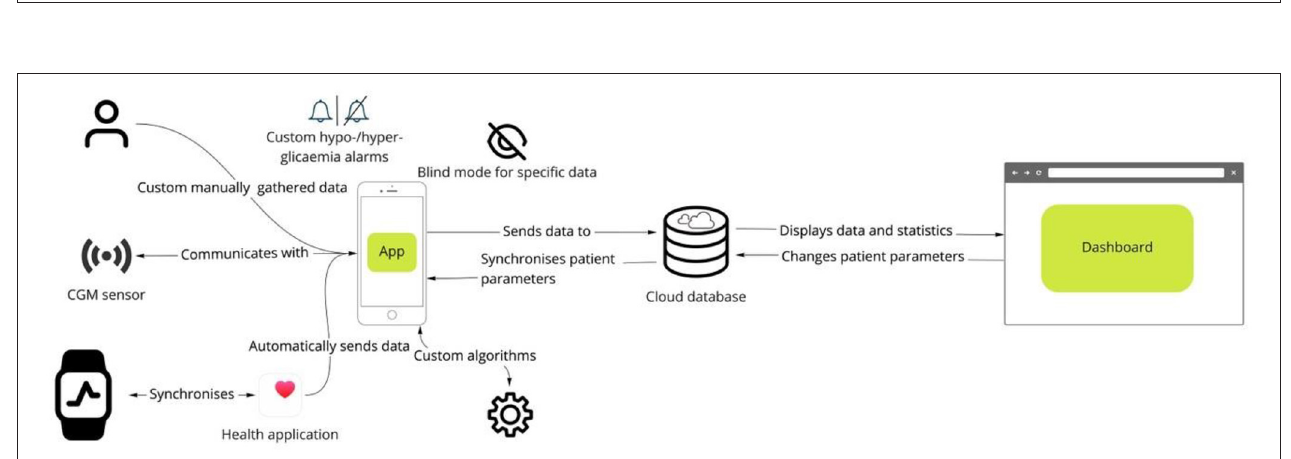
FIGURE 5 | Digital platform for multi-level data integration. The platform gathers data from multiple sources, such as manual input, continuous glucose monitoring sensors and health data from smartwatches. Custom algorithms and personalized data visualization (e.g., blinding data for specific classes of patients) allow for tailoring the functionalities to individual needs. The dashboard allows the healthcare professional to monitor data acquisition in real time and optimize